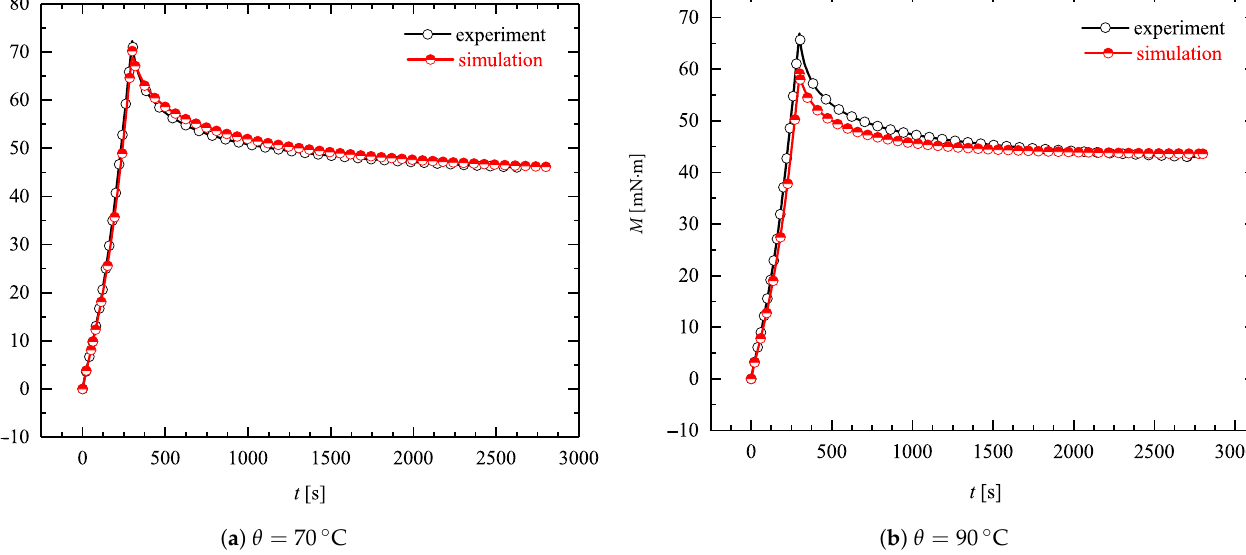
Figure 14. Experimental and simulated torque-time ( M − t ) graphs for torsion tests at two different programming tempera- tures θ = 70 ◦ C and θ = 90 ◦